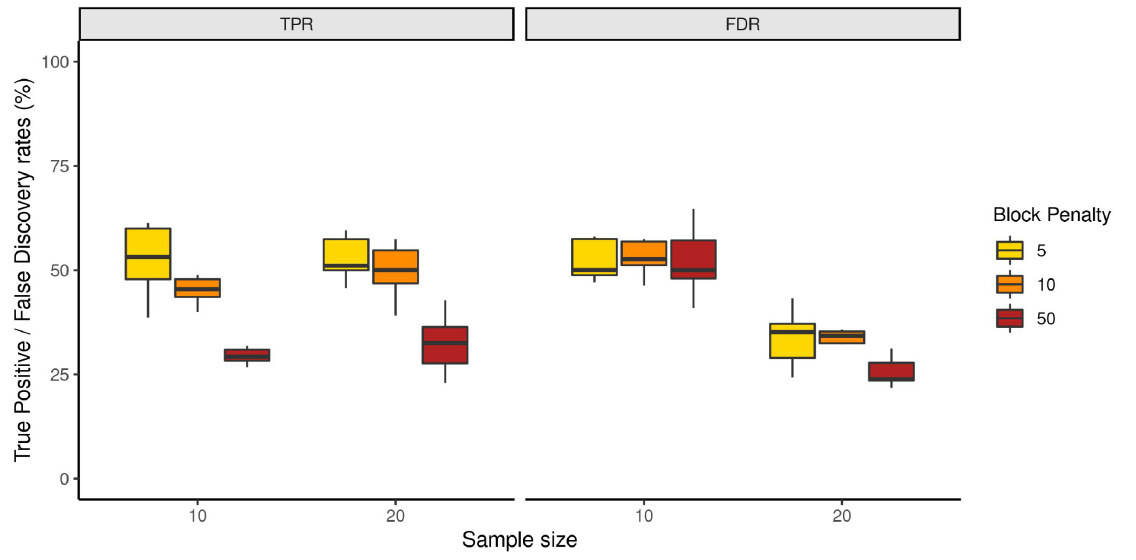
Figure 3 - Hotspot detection. True positive (TPR, left panel) and false discovery (FDR, right panel) rates of inferred, as compared to simulated hotspots, called using a detection threshold of 2.5, for different sets of methodological parameters. The sample size parameter is shown on the x axis ( i.e. 10 or 20), the block penalty ( i.e. 5, 10, 50) is shown in color, and the N e of the populations simulated is 25,000. See full results in Supplementary Figure